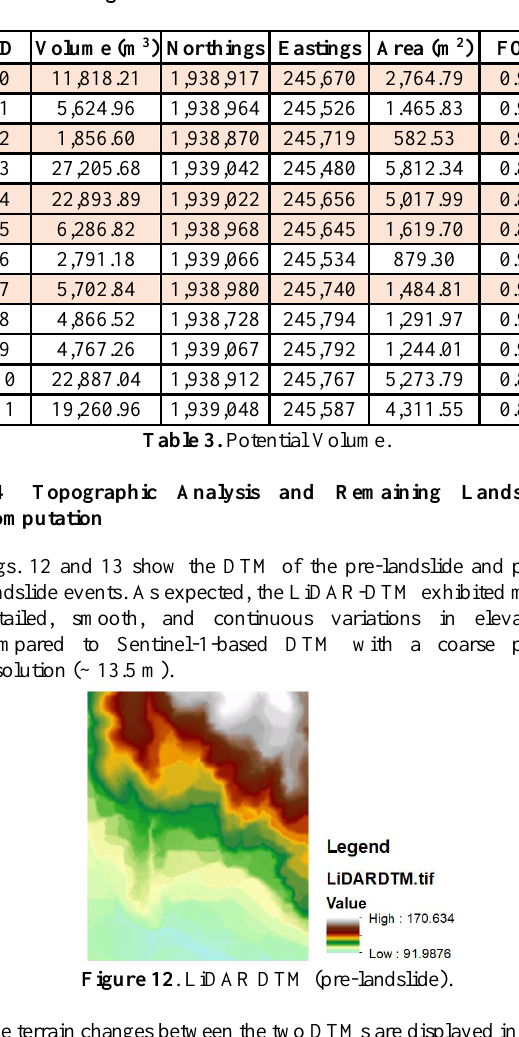
Figure 11 . Extracted Landslide Masses.